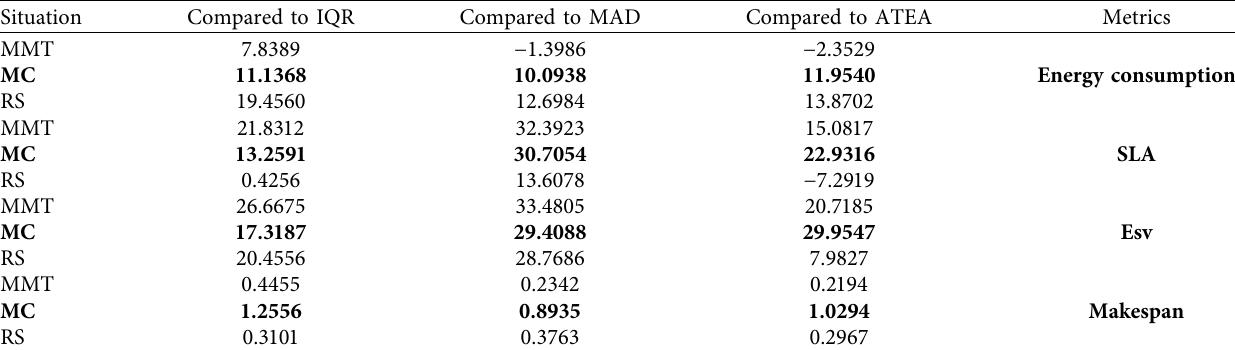
Table 6: Proposed method compared to other